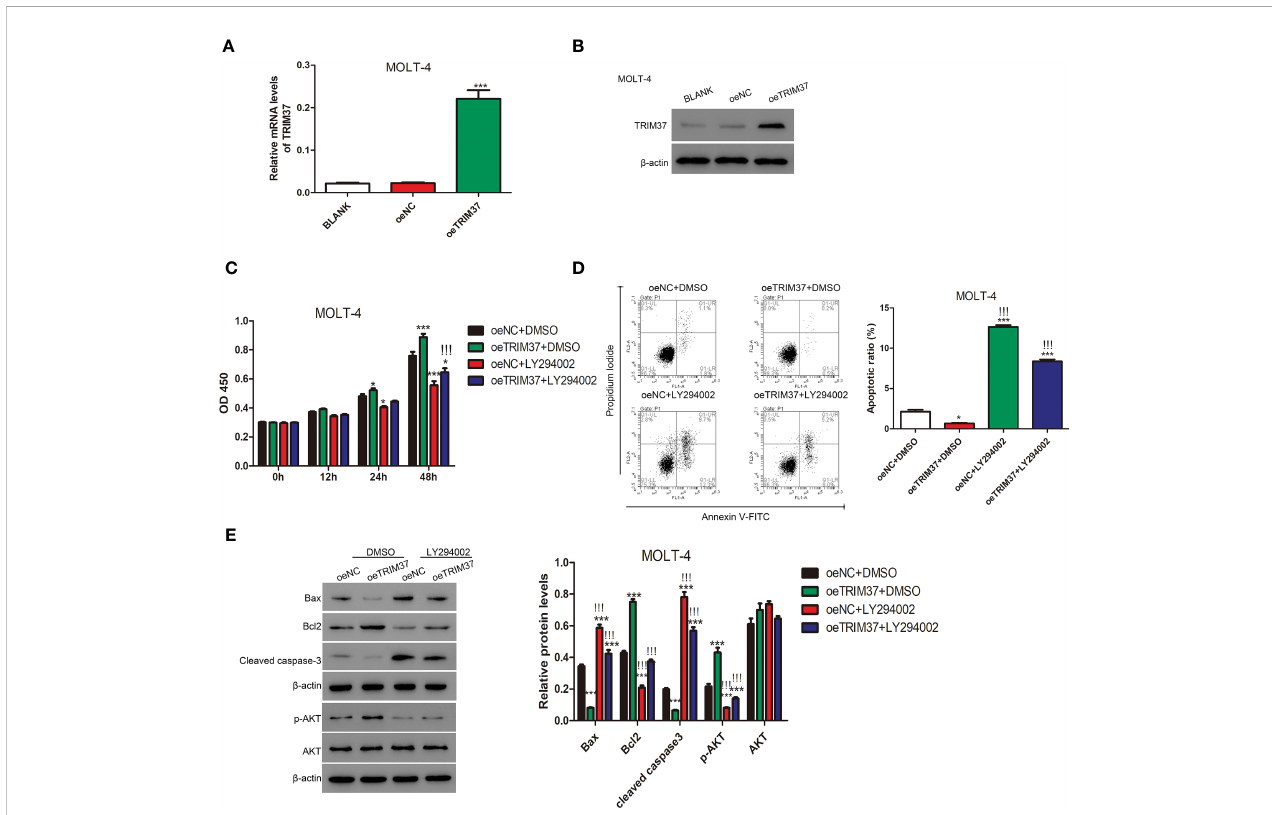
FIGURE 3 The PI3/AKT inhibitor LY294002 impaired the function of TRIM37 in human MOLT-4 cells. (A, B) The stable expression of TRIM37 in MOLT-4 cells was veri fi ed by qRT-PCR and Western blot assays. *** p < 0.001 compared with oeNC group. (C) The cell proliferation of MOLT-4 cells transduced with/or without trim37 was detected by CCK-8 assays. * p < 0.05, compared with oeNC + DMSO; *** p < 0.001 compared with oeNC + DMSO; !!! p < 0.001 compared with oeTRIM37 + DMSO. (D) The apoptosis of MOLT-4 cells transduced with/or without TRIM37 was detected by Flow cytometry. * p < 0.05 compared with oeNC + DMSO; *** p < 0.001 compared with oeNC + DMSO; !!! p < 0.001 compared with oeTRIM37 + DMSO. (E) Western blot experiments were exploited to examine the protein contents of Bax, Bcl2, cleaved caspase-3, p-AKT, and AKT in MOLT-4 cells transduced with/or without trim37. *** p < 0.001 compared with oeNC + DMSO, !!! p < 0.001 compared with oeTRIM37 +